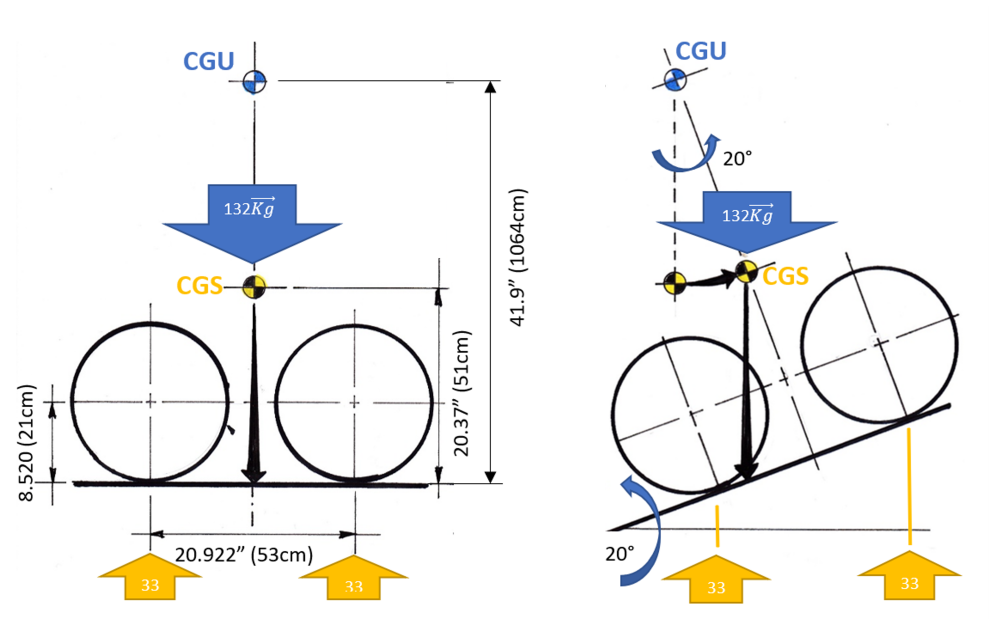
Figure 11. Simplified model of the sagittal stability system ( Left ) Coronal, ( Right )